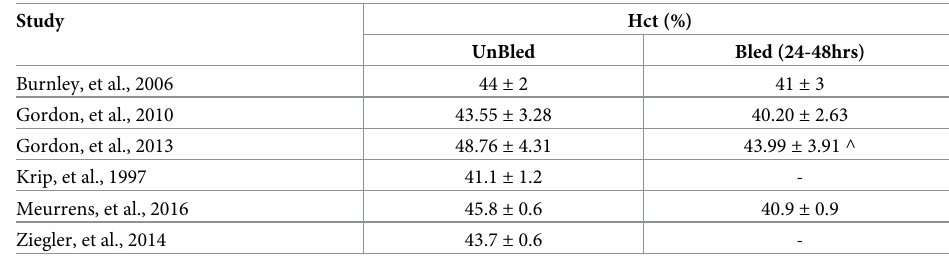
Table 6. Hct pre and post donation (Unbled and bled) values over varying time frames.